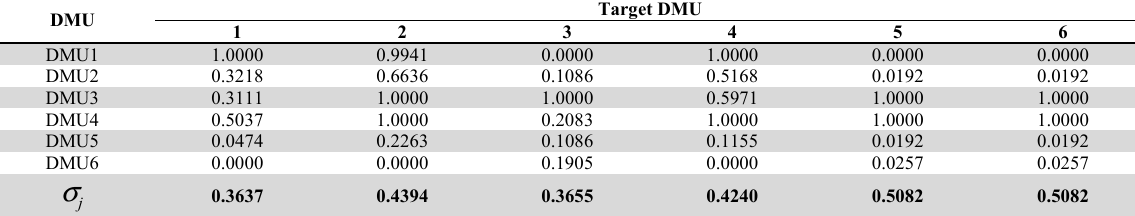
Normalized CEM of the methods of rice weevil